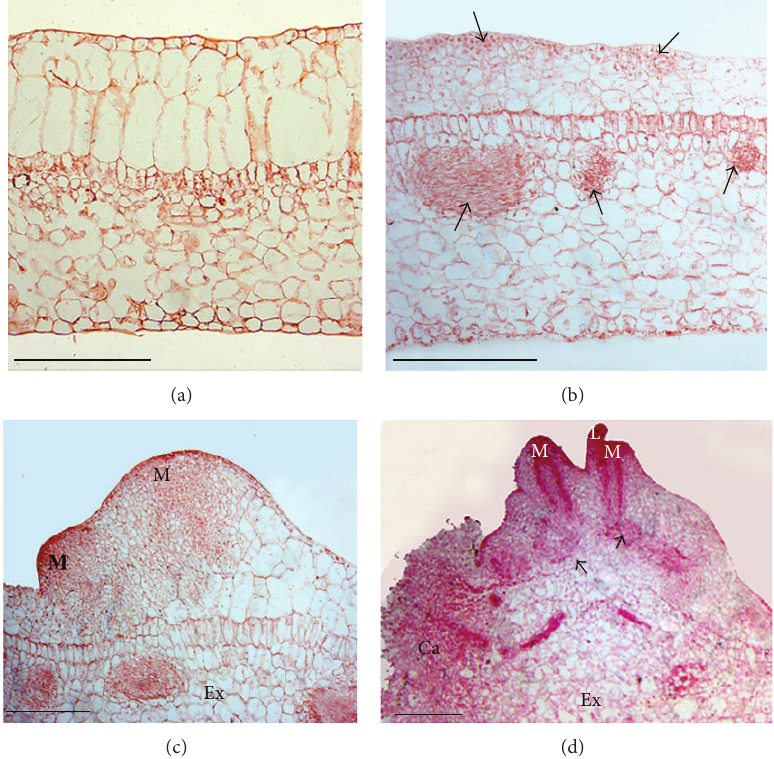
Figure 2: Histological observation of adventitious shoot formation from leaf explant of L. serratus, bar = 500 𝜇 m. (a) Leaf explant before culture initiation. (b) Cell divisions in the adaxial leaf epidermis and close to the vascular bundles ( arrowheads ) 10 days after culture initiation on medium containing 0.5 mgL −1 BA. (c) Cell division to form adventitious shoot meristems (M) from explant (Ex) 20 days after culture initiation on medium containing 0.5 mgL −1 BA. (d) Adventitious shoot with leaf primordial (L) and shoot meristems (M) formed, with vascular bundles ( arrowheads ) connected to explant (Ex) 30 days after culture on medium containing 0.5 mgL −1 BA and 0.05mg L −1 NAA. Ca indicates callus at the cutting